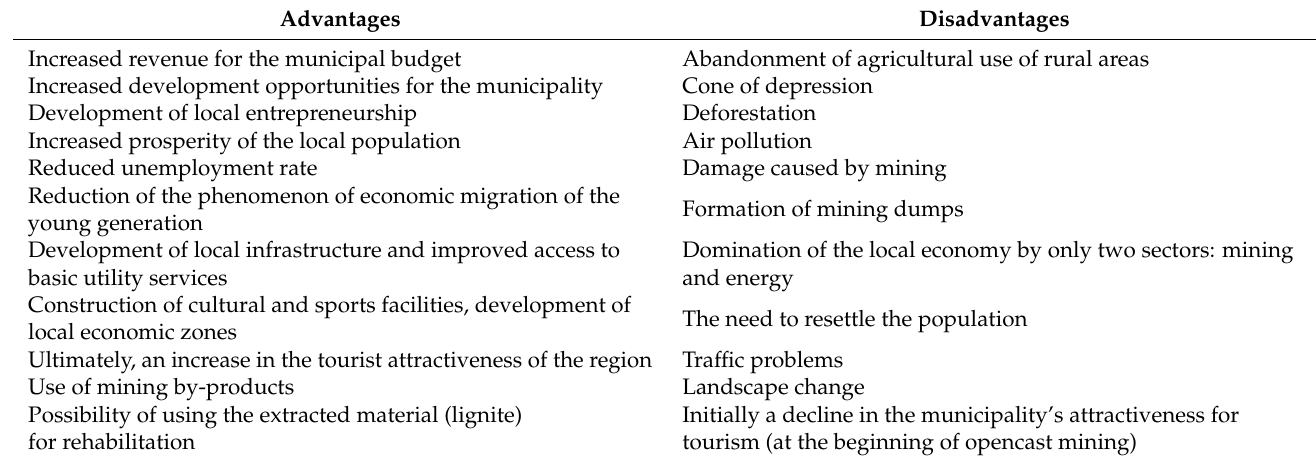
Table 12. Advantages and disadvantages of opencast mining in rural